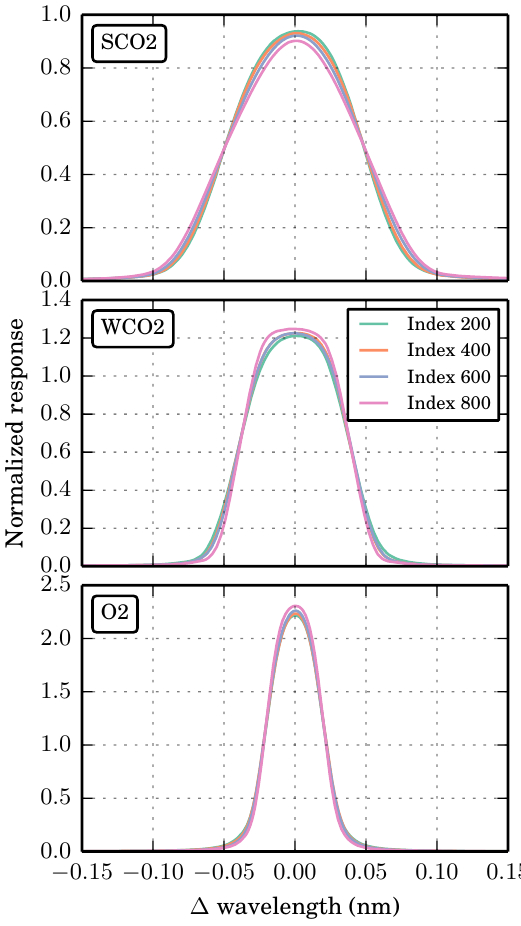
Figure 2. OCO-2 ILSs for a center footprint (#4) at four different spectral positions for each band independently. FWHM values are Fig. 2. OCO-2 instrument line-shape functions (ILS) for a center about 0.04, 0.075 and 0.1nm for the O2, WCO2 and SCO2 bands, footprint (#4) at 4 different spectral positions for each band inde- pendently. Full width at Half Maximum (FHWM) are about 0.04, 0.075 and 0.1 nm for the O2, WCO2 and SCO2 band, respectively.